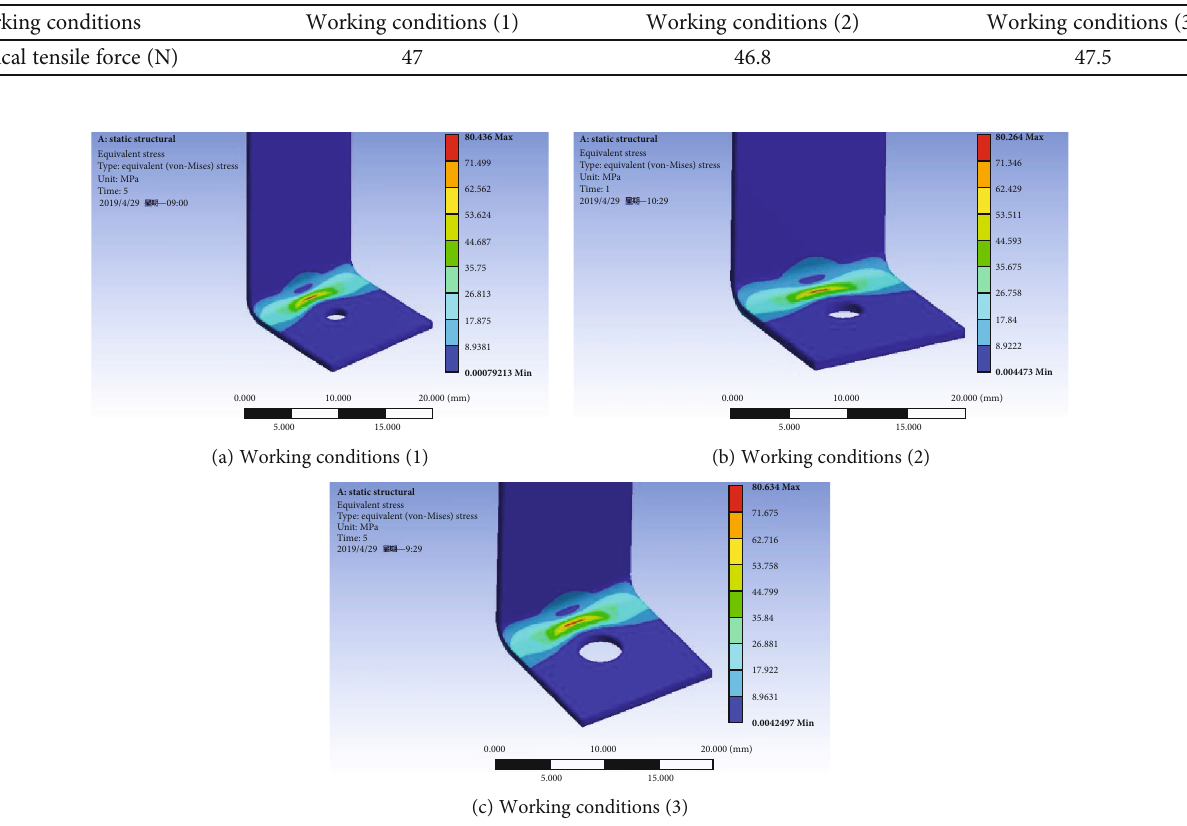
Figure 17: Stress cloud map corresponding to the change of the opening diameter of nylon